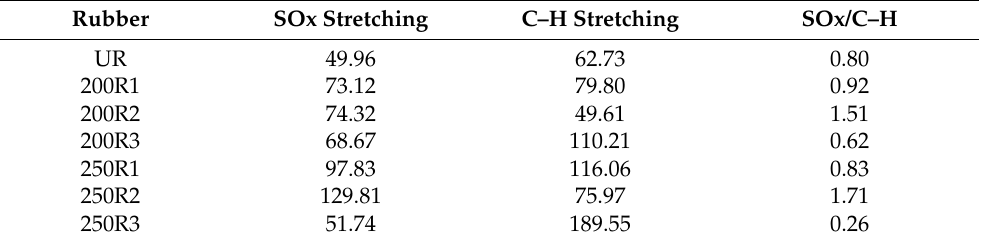
Table 1. The SOx/C–H area ratios of the reacted rubber crumbs at 200 ◦ C and 250 ◦ C. Rubber SOx